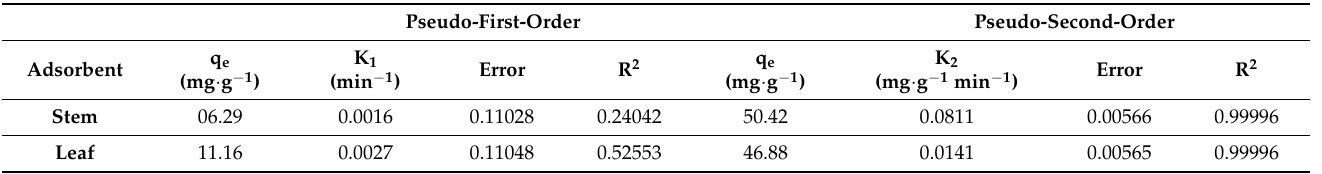
Table 2. Constant of the kinetic models of the stem and leaf of water hyacinth ( Eichhornia Crassipes ) in the adsorption of the methylene blue cationic dye.